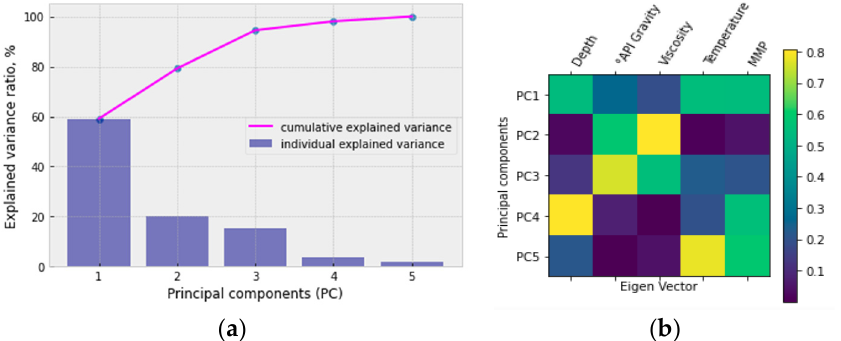
Figure 8. ( a ) Scree plot and ( b ) eigenvectors of PCA for miscible CO 2 -EOR simultaneous screening model A.